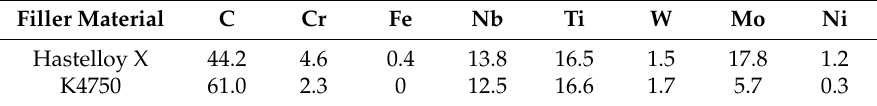
Figure 7. TEM analyses of carbides in weld fusion zone: ( a ) MC carbides in K4750 weld metal and inset is the SADP of the arrow marked MC; ( b ) MC carbides in Hastelloy X weld metal and inset is the SADP of the arrow marked MC; and ( c ) SADP of K4750 weld metal matrix area reveals no superlattice reflections of the γ’ phase. Table 3. MC carbide compositions in fusion zone with various filler material (Atomic %).